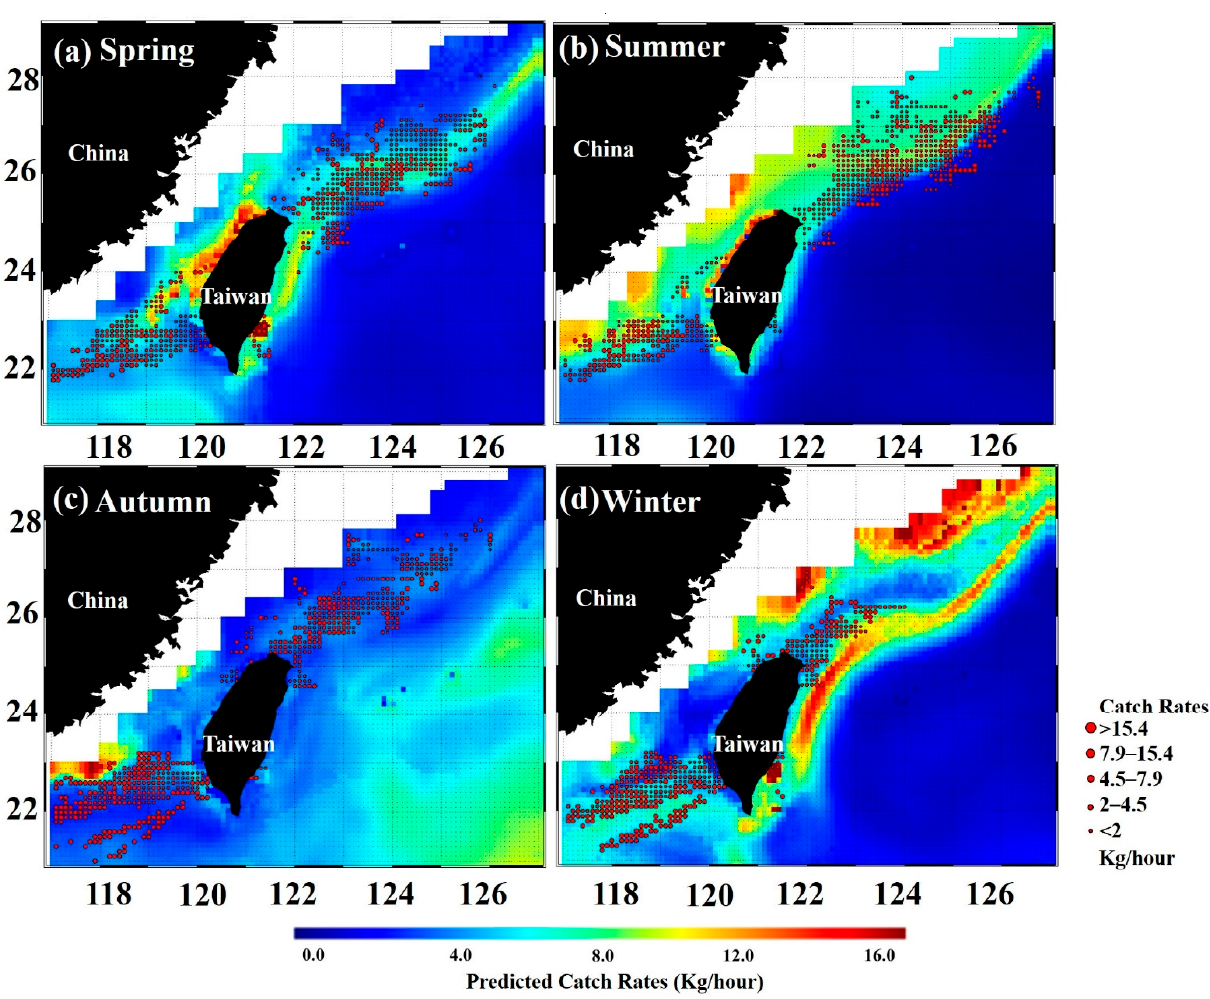
Figure 8. Seasonal average spatiotemporal distribution pattern of observed catch rates for S. dumerili overlaid with predicted catch rates from selected GAMs in the 2014–2017 period in the TS: ( a ) spring, ( b ) summer, ( c ) autumn, and ( d ) winter. High S. dumerili catch rates were observed in the northern part of the TS, extending to 25°N–28°N and 122°E–126°E during the summer. Thus, the model-predicted catch rates were reliable, and they correlated well with the observed S. dumerili catch rates in the TS. Seasonal fluctuations in the predicted and RMSD values for S. dumerili were observed in 2019. In winter, spring and summer, the predicted values increased, whereas, in autumn, the predicted values decreased. Seasonally, the RMSD value was calculated as 0.35–0.48 (Table 4).